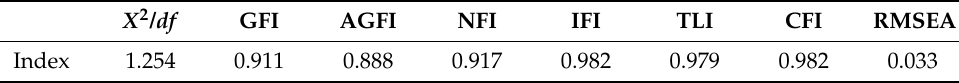
Table 6. Model fit